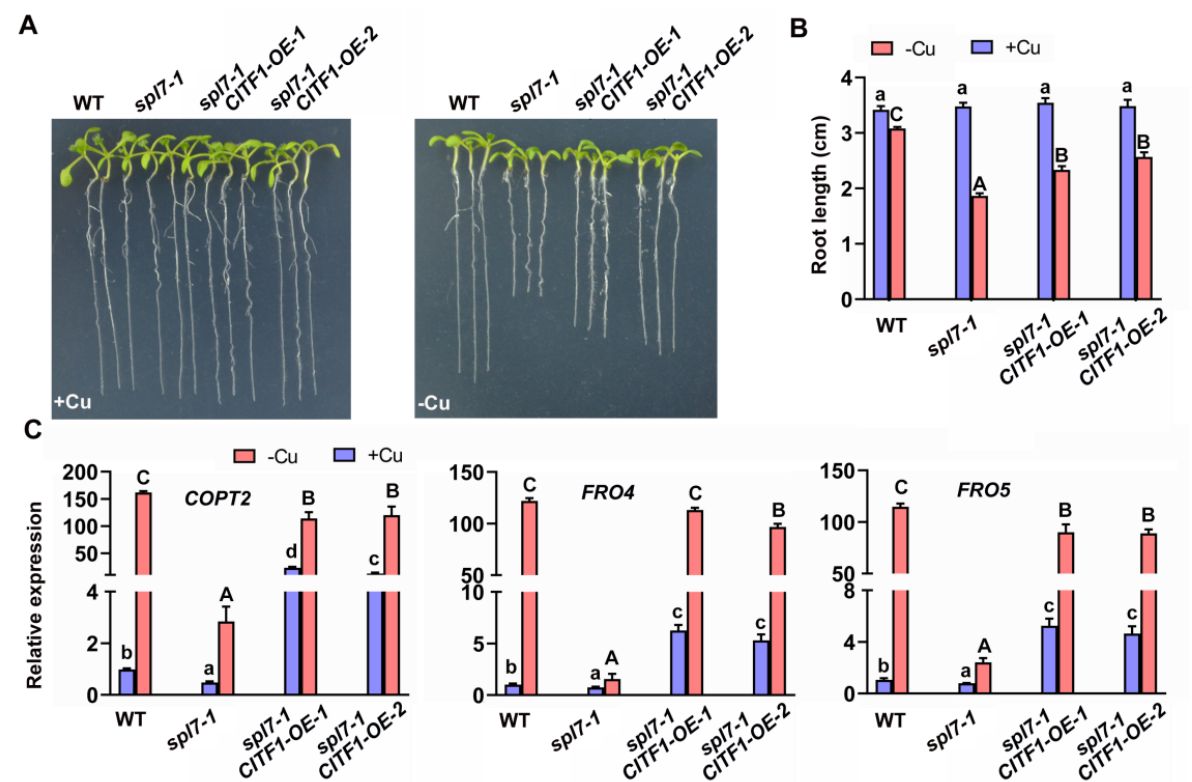
Figure 3. Overexpression of CITF1 partially rescues spl7-1 . ( A ) Phenotypes of seedlings. Seedlings grown on +Cu or − Cu medium for 7 days are shown. ( B ) Root length. Seven-day-old seedlings were analyzed. Three biological replicates were conducted. Data represent arithmetic means ± SD ( n = 3 biological replicates, each of which contained at least 15 plants). Different letters above each bar indicate statistically significant differences (ANOVA, p < 0.01). ( C ) Expression of Cu-deficiency responsive genes. Seedlings were grown on +Cu or − Cu medium for 7 days. Roots were used for RNA extraction. Data represent arithmetic means ± SD ( n = 3). Different letters above each bar indicate statistically significant differences (ANOVA, p < 0.01).